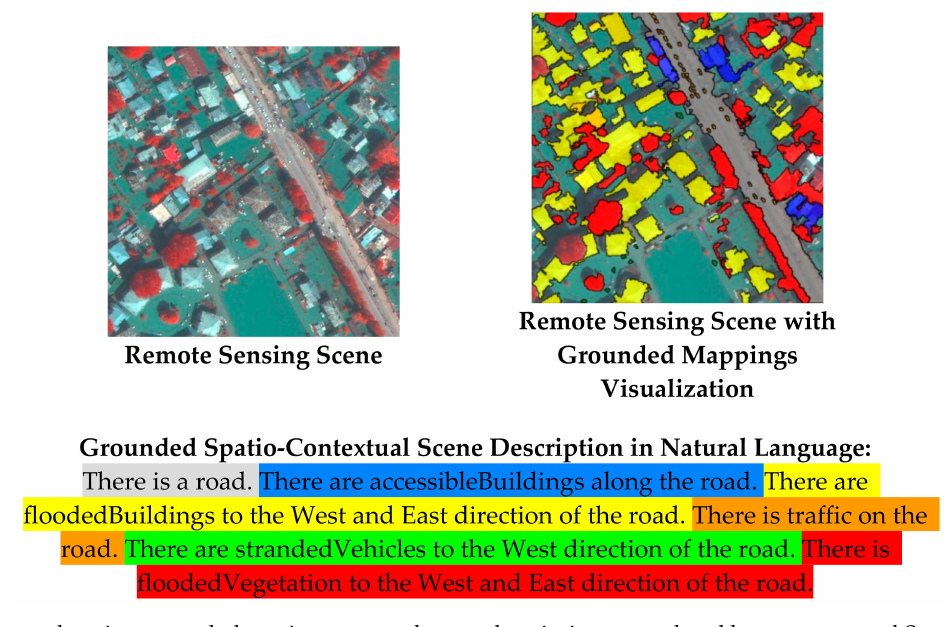
Figure 1. Comprehensive grounded spatio-contextual scene description as rendered by our proposed Semantics-driven Remote Sensing Scene Understanding (Sem-RSSU) for a remote sensing scene of urban floods, depicting explainability by color-coded mapping of sentences to regions of interest in the